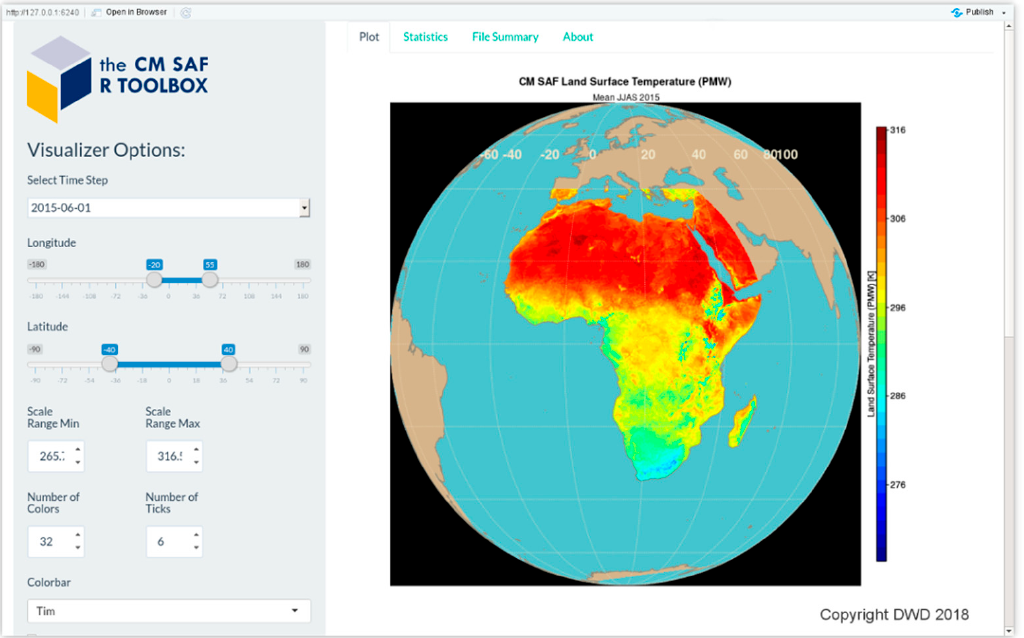
Figure 2. The interface of the R-shiny based CMSAF_Visualizer.R application.